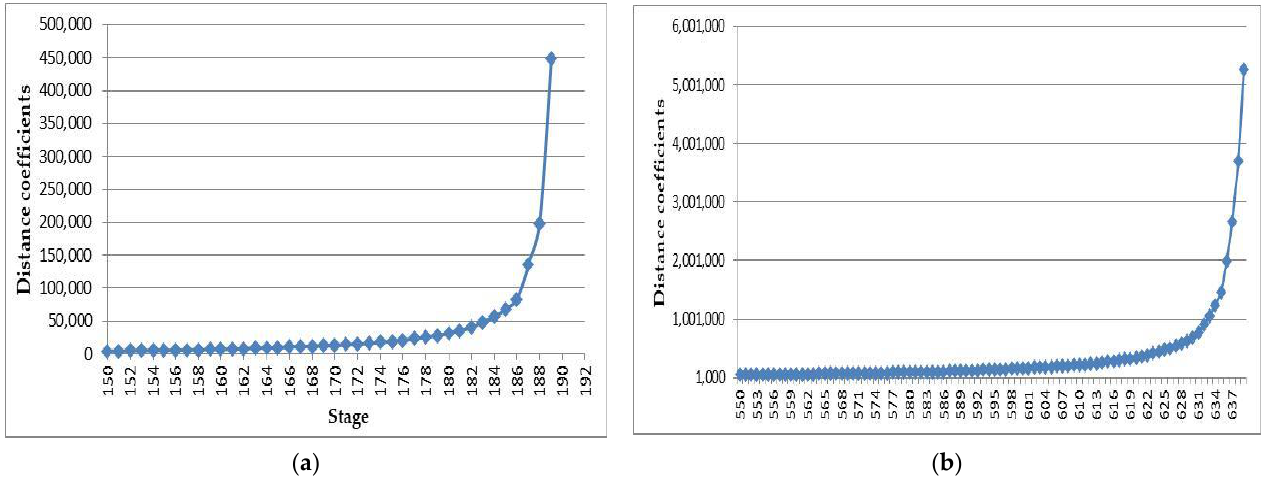
Figure 4. Number of clusters based on Elbow method: ( a ) Hungarian companies. ( b ) Romanian companies. Source: Authors ’ own editing, based on own calculations.